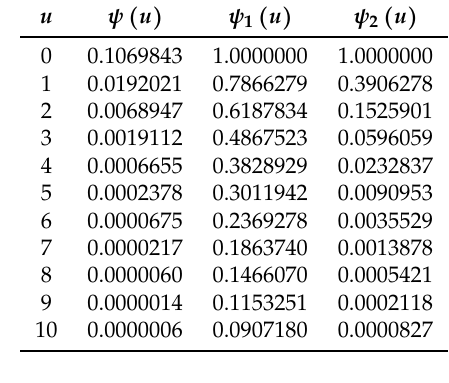
Table 1. Values and estimates of ruin probability for model of Example 1.